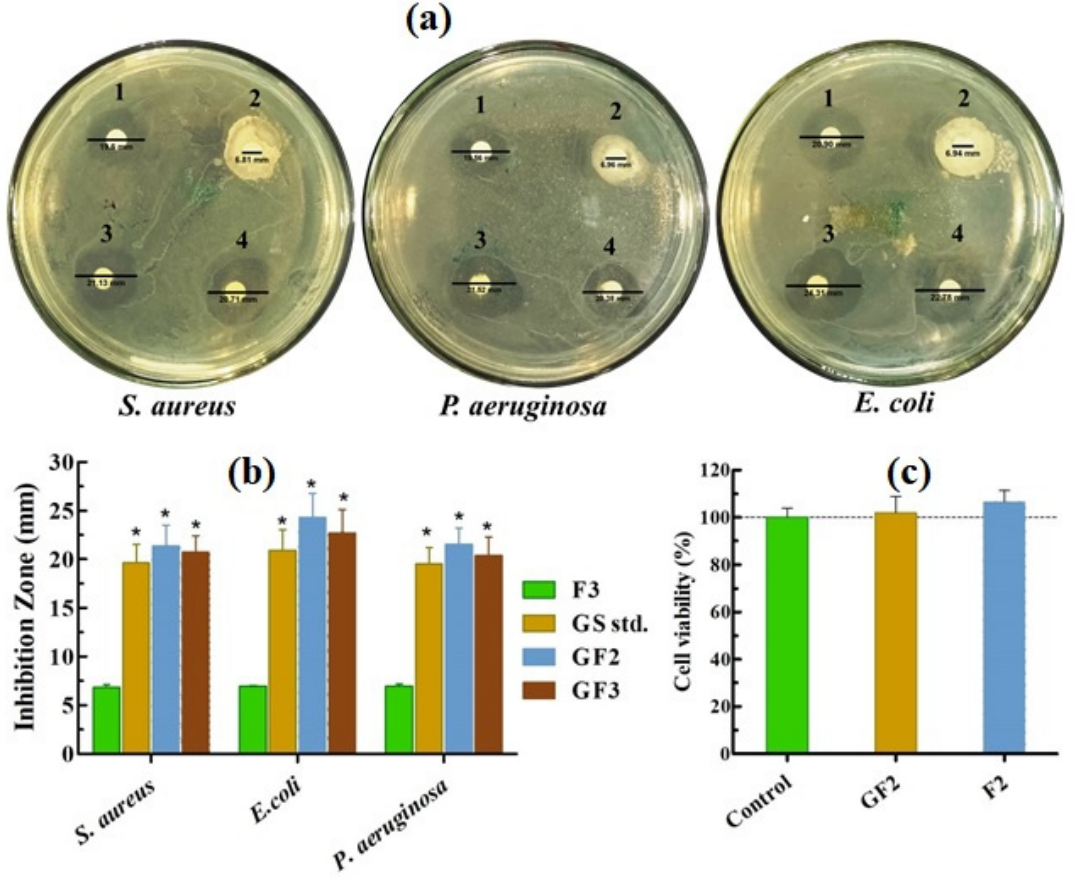
Figure 6. ( a ) Antibacterial effect of F3 (1), gentamicin sulphate (GS) (2), GF2 (3), GF3 (4); ( b ) inhibition zones and ( c ) cell viability of arabinoxylan (AX)-sodium alginate (SA) films (mean ± SD, n = 3). Asterisk (*) indicate statistically significant difference ( p < 0.05) as compared to blank film (F3).